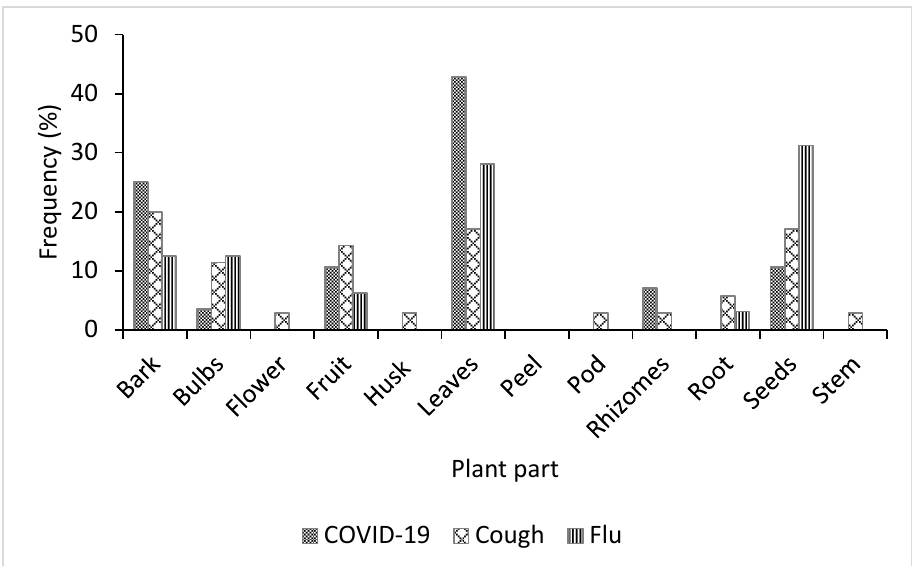
Figure 3. Frequency of plant parts used for treating COVID-19, cough, and flu in Ogbomosho North and South Local Government Areas, Oyo State, Nigeria.